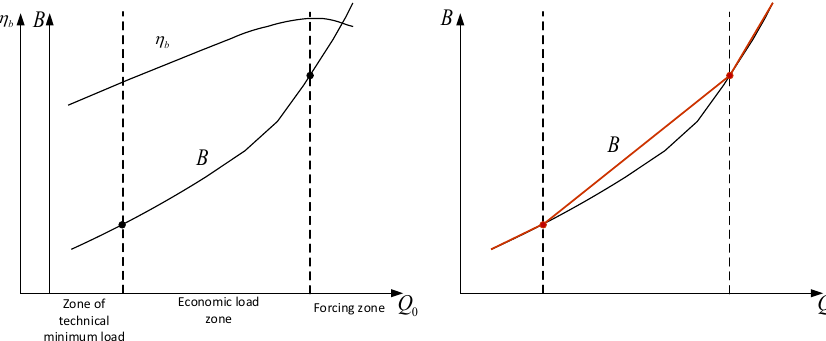
Fig. 1. General view of CHP boiler fuel consumption characteristic: a) Consumed; b)